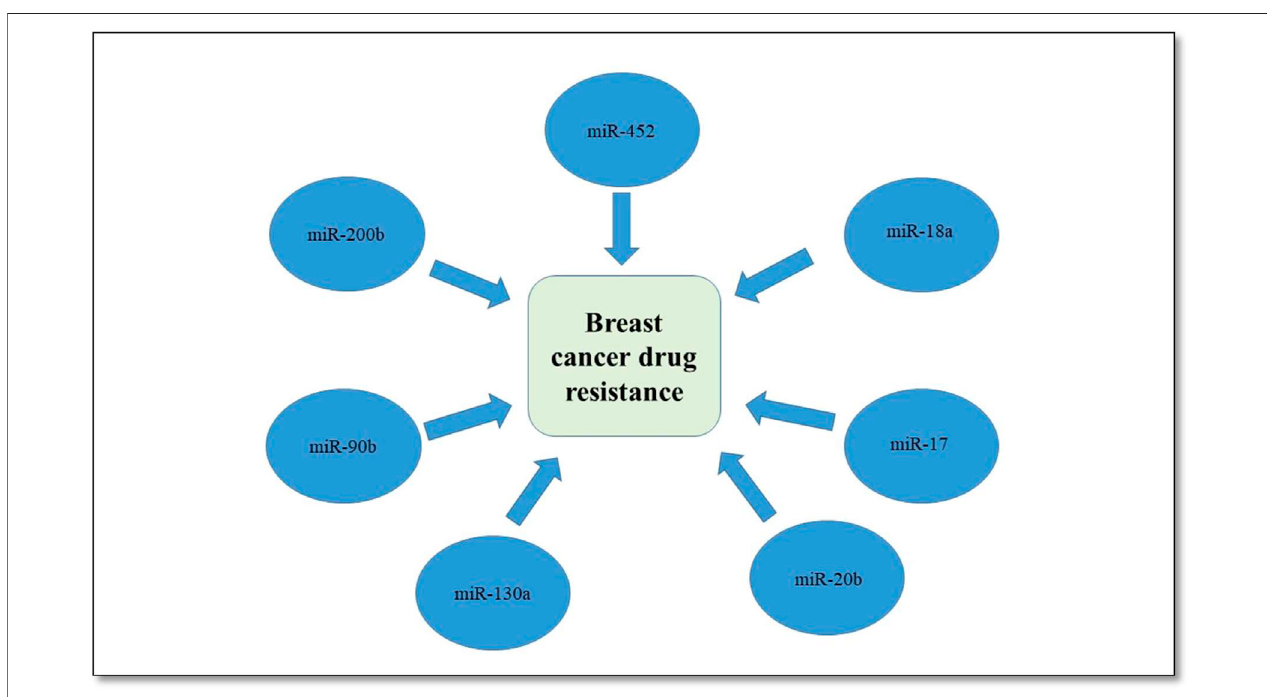
FIGURE 1 | Role of different miRNA in drug